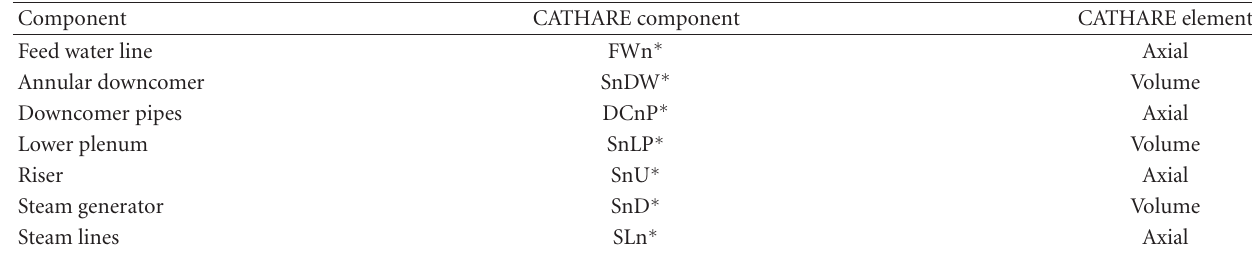
Table 2: Main components of the PKL secondary side.